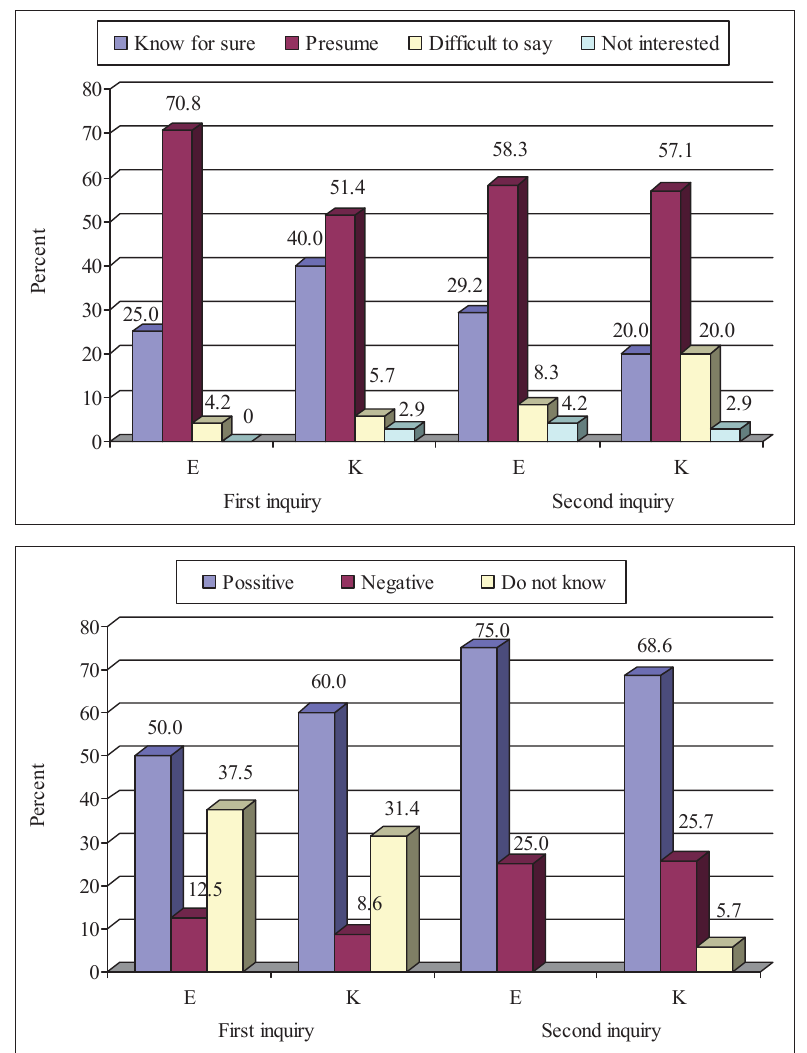
Figure 1. Percentage distribution of awa- reness of physical abilities which were de- veloped by the schoolboys during physical education lessons